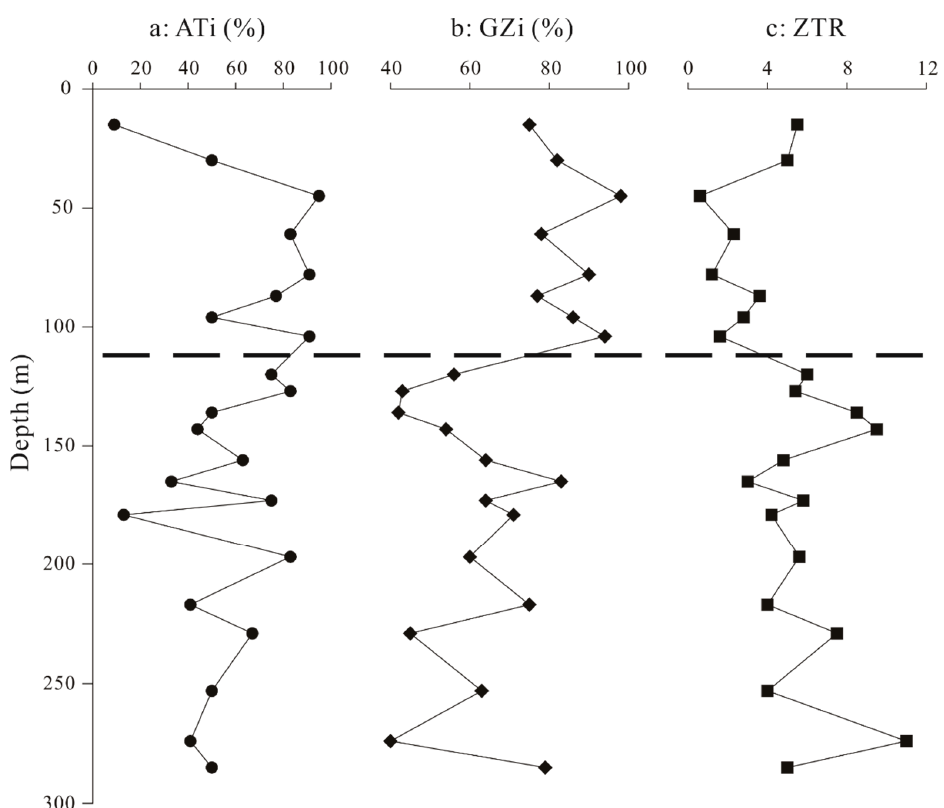
Figure 6. Variations in the indexes of ATi, GZi, and ZTR for the Zhoulao core sediments. All three curves show a significant transition at a depth of about 110 m. Table 2. Variation in ATi, GZi, and ZTR indexes through the Zhoulao core.